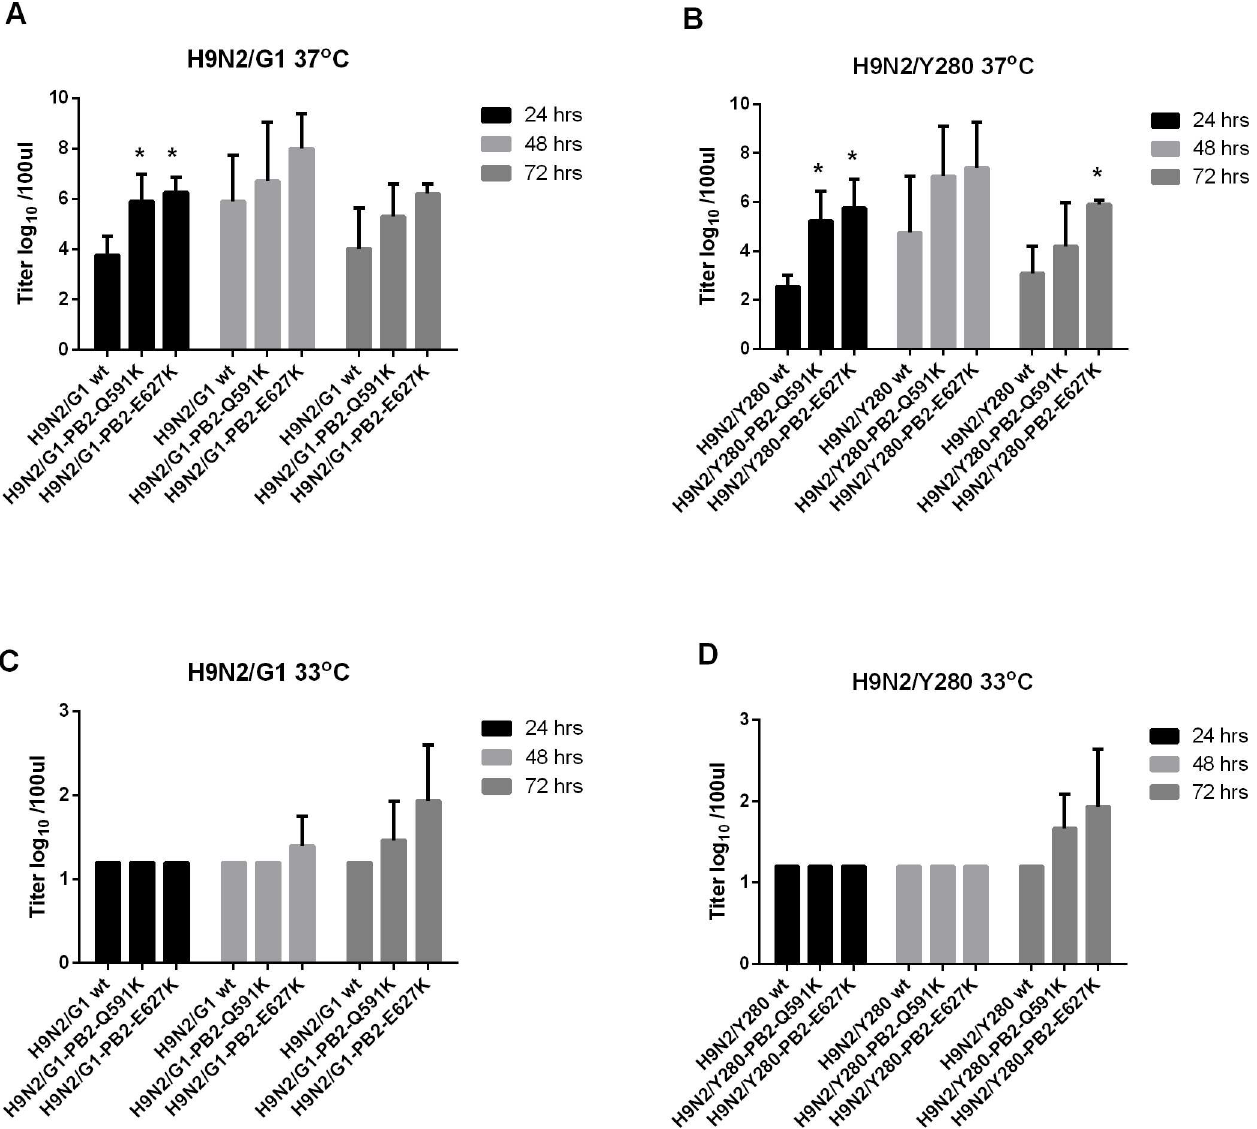
Fig 2. Virus replication of primary NHBE cells infected by H9N2 viruses. Primary NHBE cells were infected at MOI of 2 with H9N2/G1 or H9N2/Y280 and their PB2 variants. The virus titers were measured from the supernatantof 24, 48 and 72 hours post-infection by TCID50